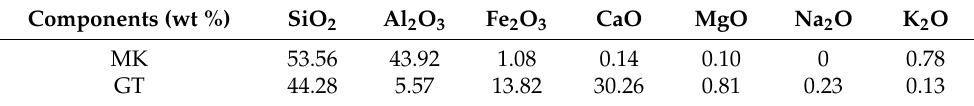
Table 1. The main chemical constituents of garnet and